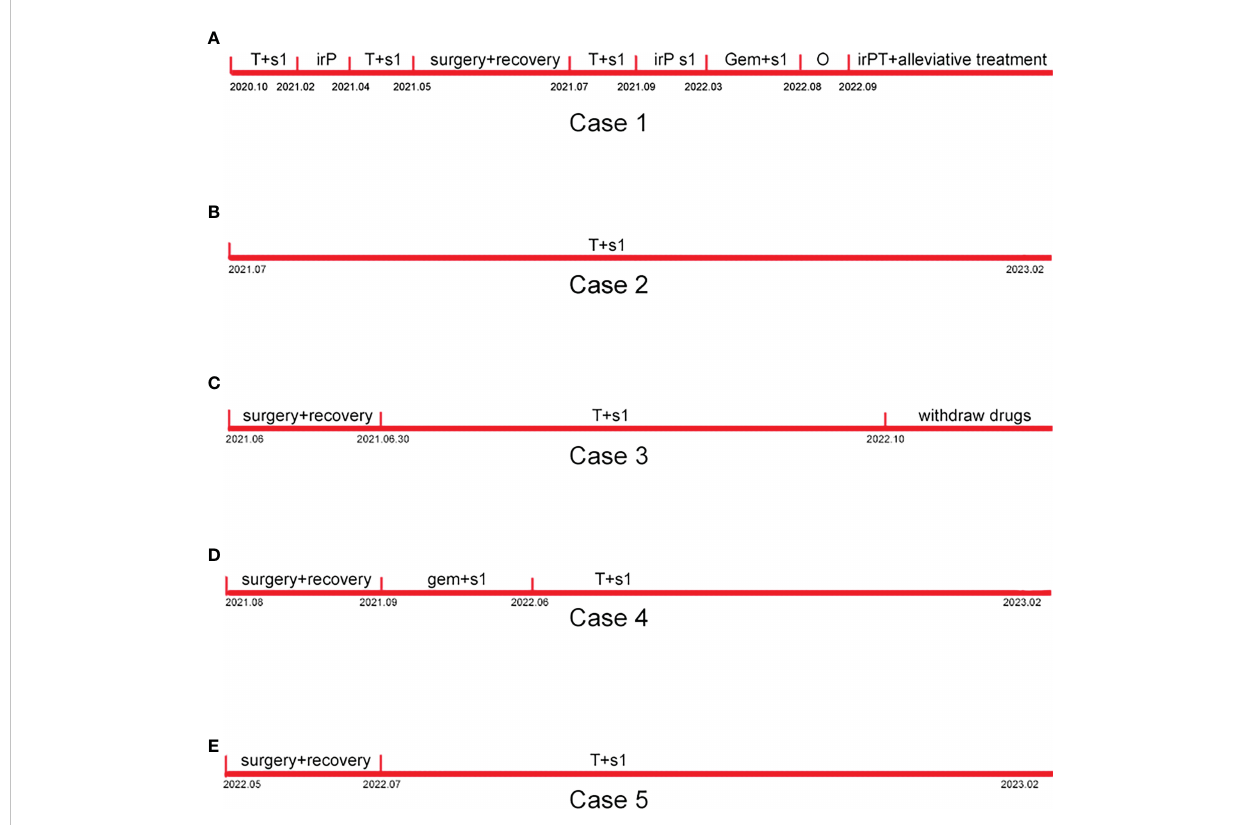
FIGURE 4 Timelines of Case 1-5. (A) The timeline of case 1. (B) The timeline of case 2. (C) The timeline of case 3. (D) The timeline of case 4. (E) The timeline of case